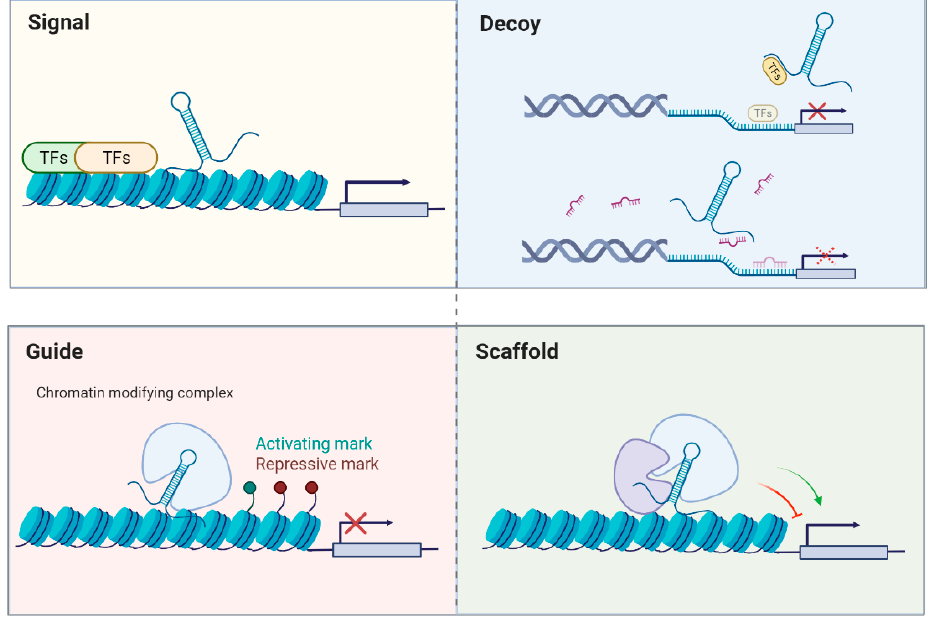
Figure 1. General modes of action of lncRNAs. (Adapted from [7])